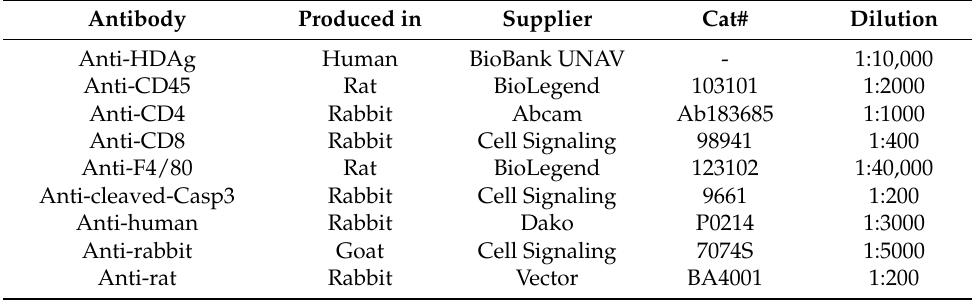
Table 1. Description of the antibodies used in immunohistochemistry